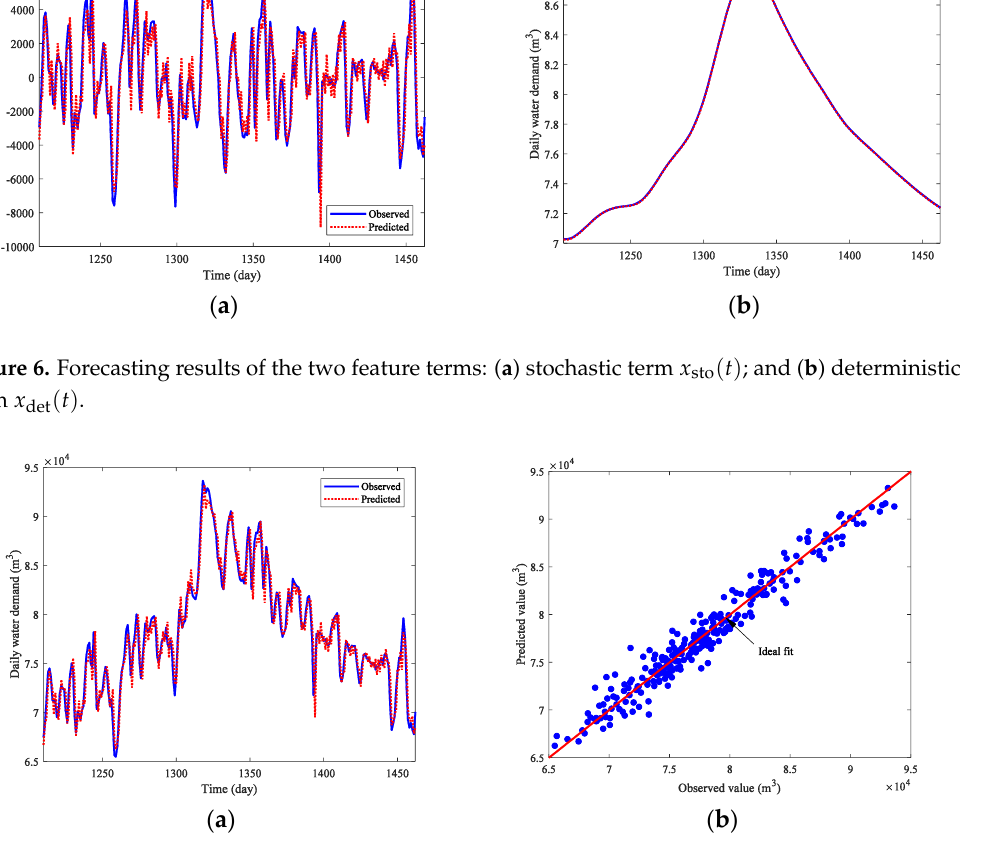
Figure 7. Final forecasting results of the daily water demand: ( a ) comparison between the predicted value and the observed value; and ( b ) the scatter of the predicted value and the observed value.